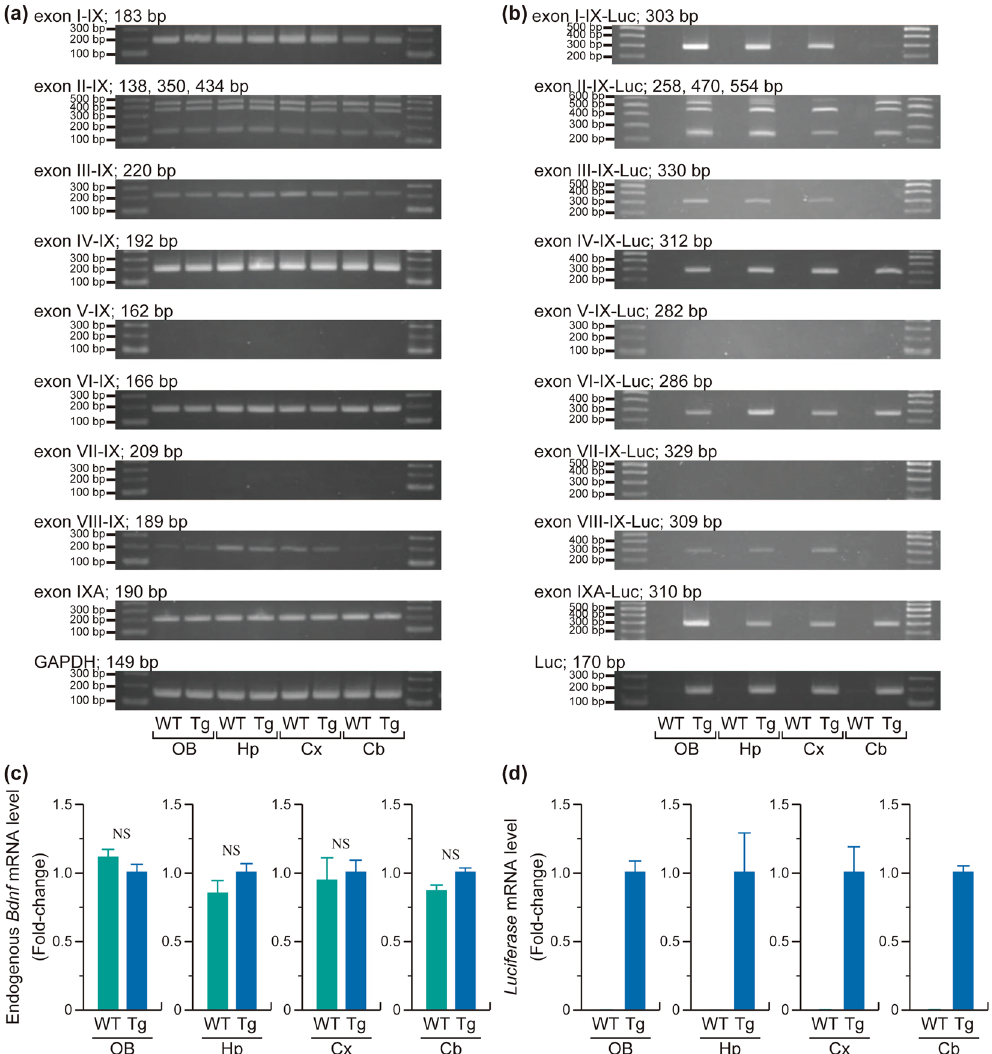
Figure 2. Expression of Bdnf and Bdnf - Luc mRNA in the brain of wild-type or Bdnf - Luc Tg mice. Total RNA was extracted from olfactory bulb (OB), hippocampus (Hp), cerebral cortex (Cx), and cerebellum (Cb) of wild-type (WT) or Bdnf - Luc Tg (Tg) mice. The expression of endogenous Bdnf ( a ) and Bdnf - Luc mRNA ( b ) was investigated by RT-PCR analysis. To distinguish alternative BDNF transcripts, we used a 5 ′